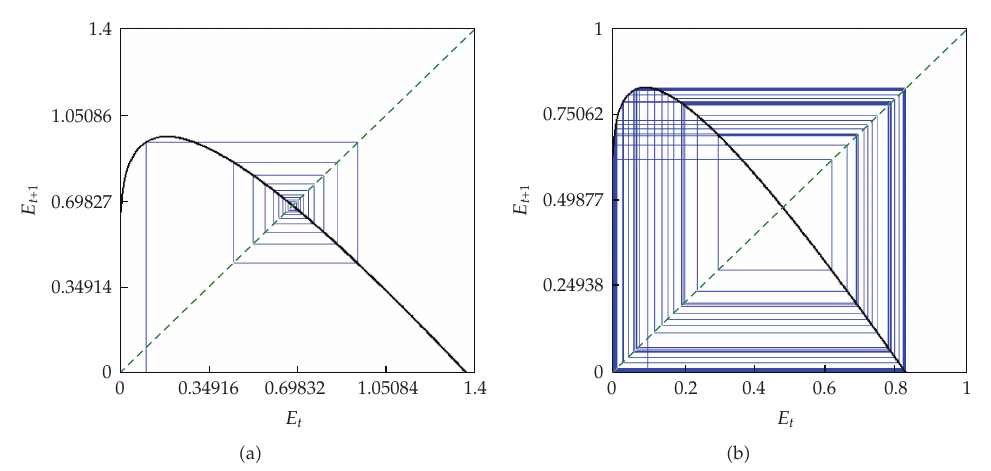
Figure 1: (cid:5) a (cid:6) Globally stable equilibrium. (cid:5) b (cid:6) Chaotic